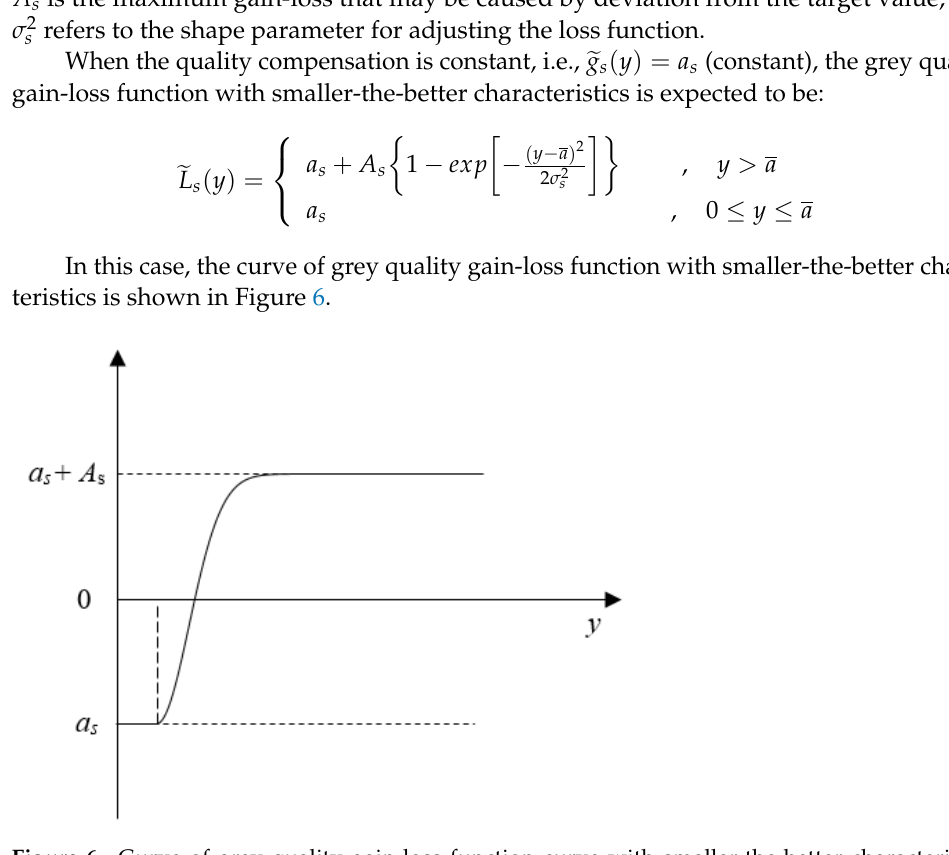
Figure 6. Curve of grey quality gain–loss function curve with smaller-the-better characteristics ( ( ) g y a =  (constant)). ( (cid:101) g s ( y ) = a s s s